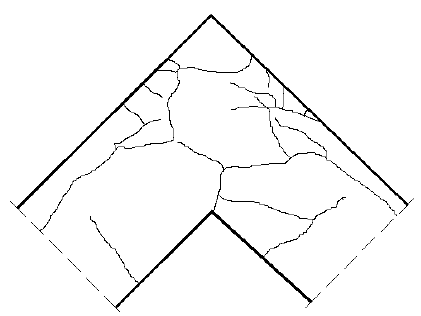
Figure 34. ( a – d ) PEEQT maps in FEM analysis in four selected time steps.